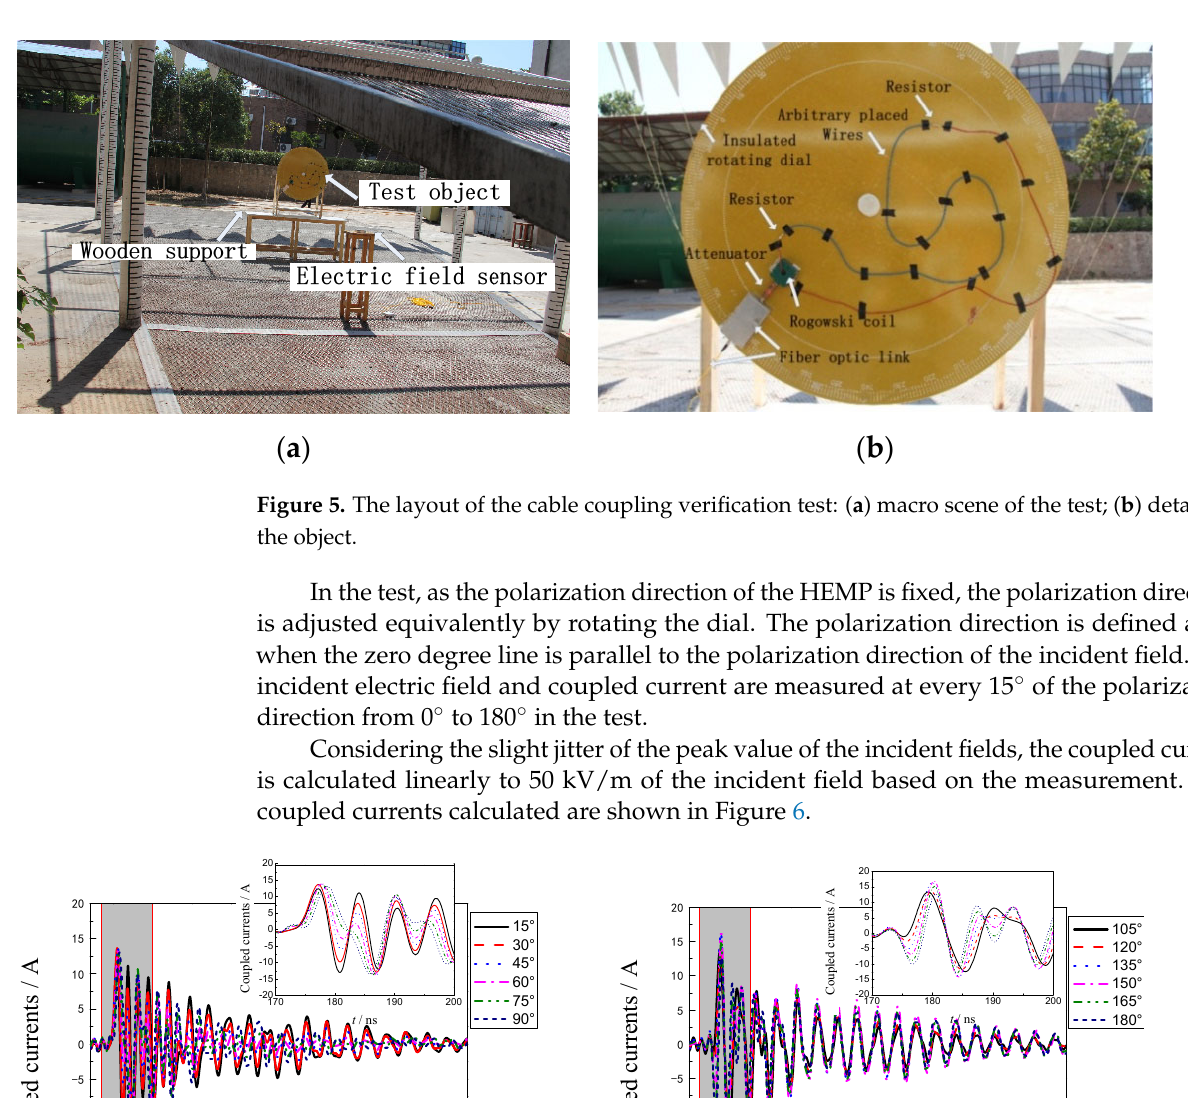
( b ) Figure 4. The normalized waveform and spectrum of the incident electric fields: ( a ) the waveform; ( b ) the spectrum. The layout of the test is shown in Figure 5. The test object and electric field sensor are illuminated in the electromagnetic wave generated by the simulator. The test object is placed over the insulated wooden support. Two wires connected by two 50 Ohm resistors are placed randomly on the insulated rotating dial with a scale. Coupled currents on the